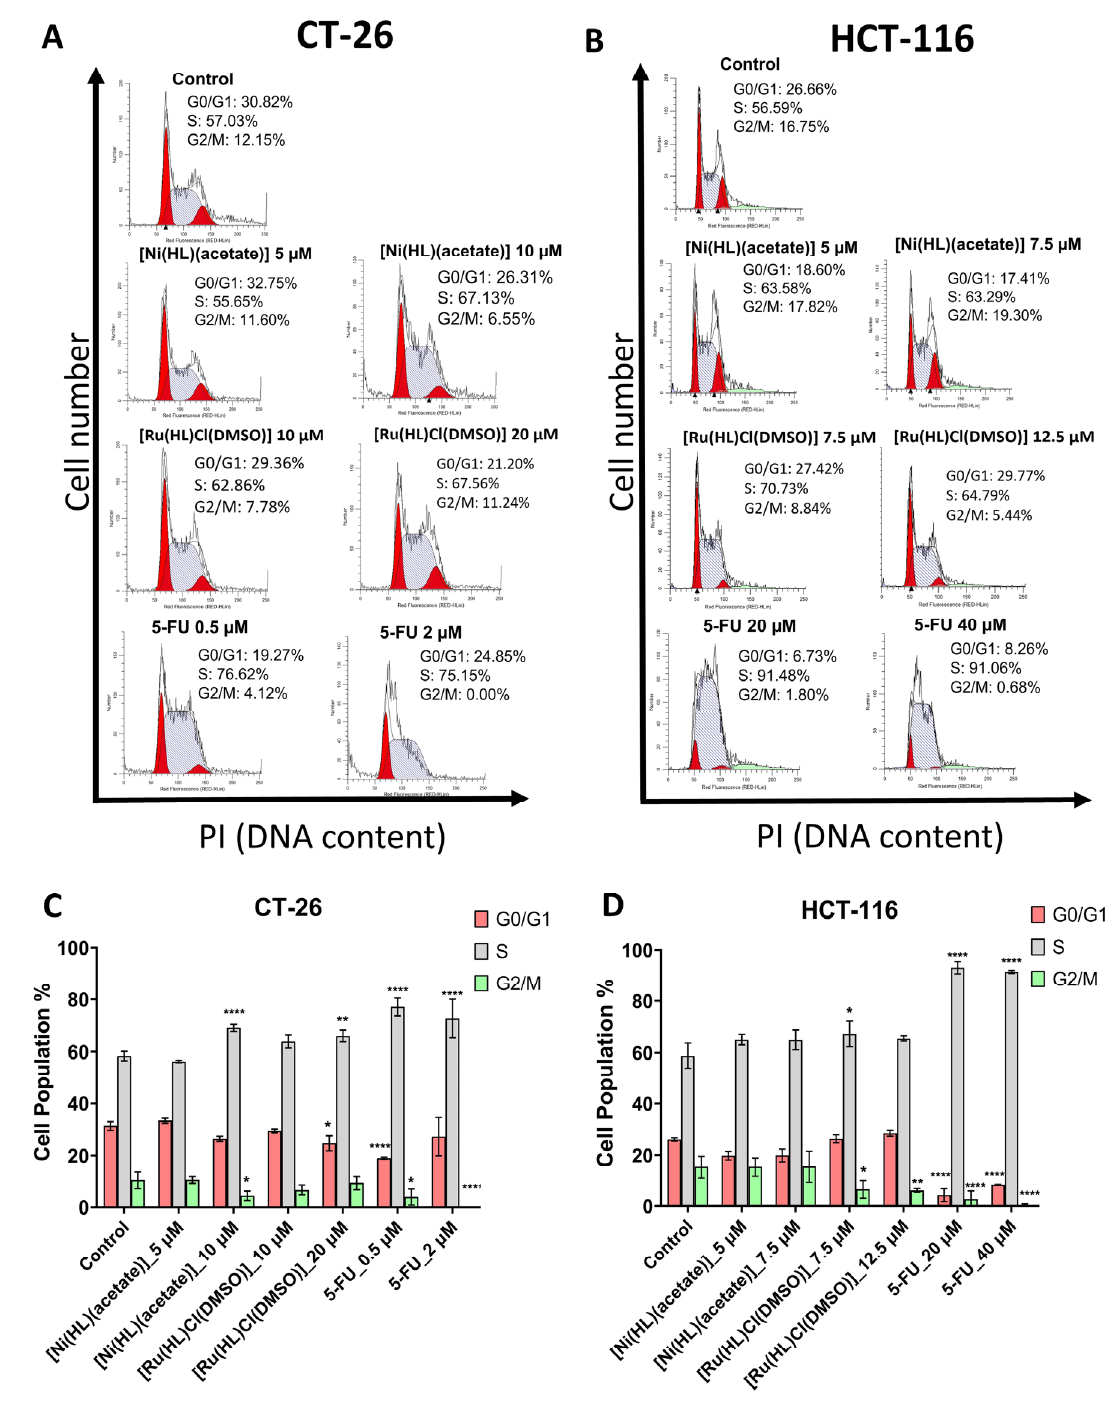
Figure 10. Representative histograms of CT-26 ( A ) and HCT-116 ( B ) cell cycle analysis. ( C ) Distribution of CT-26 cell population in % at different cell cycle phases after incubation with complete medium (control) or with [Ni(HL)(acetate)] at 5 and 10 µ M, [Ru(HL)Cl(DMSO)] at 10 and 20 µ M and 5-FU at 0.5 and 2 µ M, for 24 h. ( D ) Distribution of HCT-116 cell population, in %, at different cell cycle phases after incubation with complete medium (control) or with [Ni(HL)(acetate)] at 5 and 7.5 µ M, [Ru(HL)Cl(DMSO)] at 7.5 and 12.5 µ M and 5-FU at 20 and 40 µ M, for 24 h. Data are expressed as mean ± SD of two independent experiments. * p < 0.05, ** p < 0.01, **** p < 0.0001 vs. control.